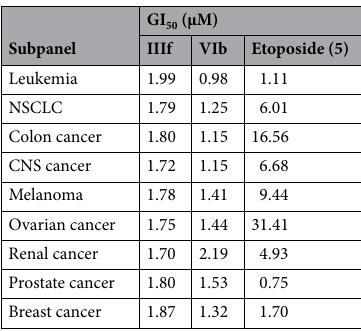
Table 4. Mean GI 50 concentrations (µM) of ( IIIf ), ( VIb ) and etoposide ( 5 ) across various subpanels in the NCI-60 human tumor cell lines screen five-dose assay. Corrected average is used to express inhibition more accurately, minimizing the effect of the outlier value of NCI/ADR-RES cell line.